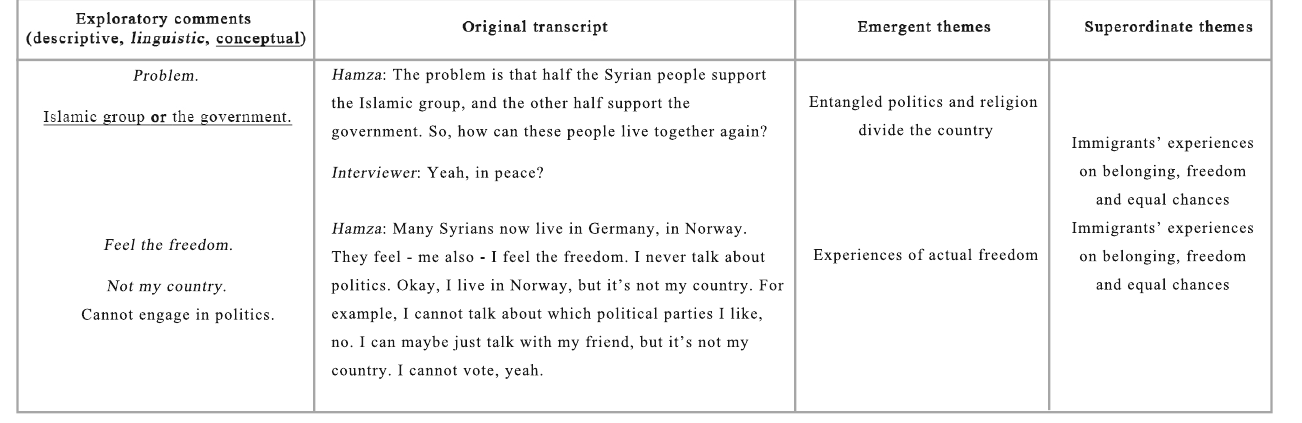
Figure 1. Example of